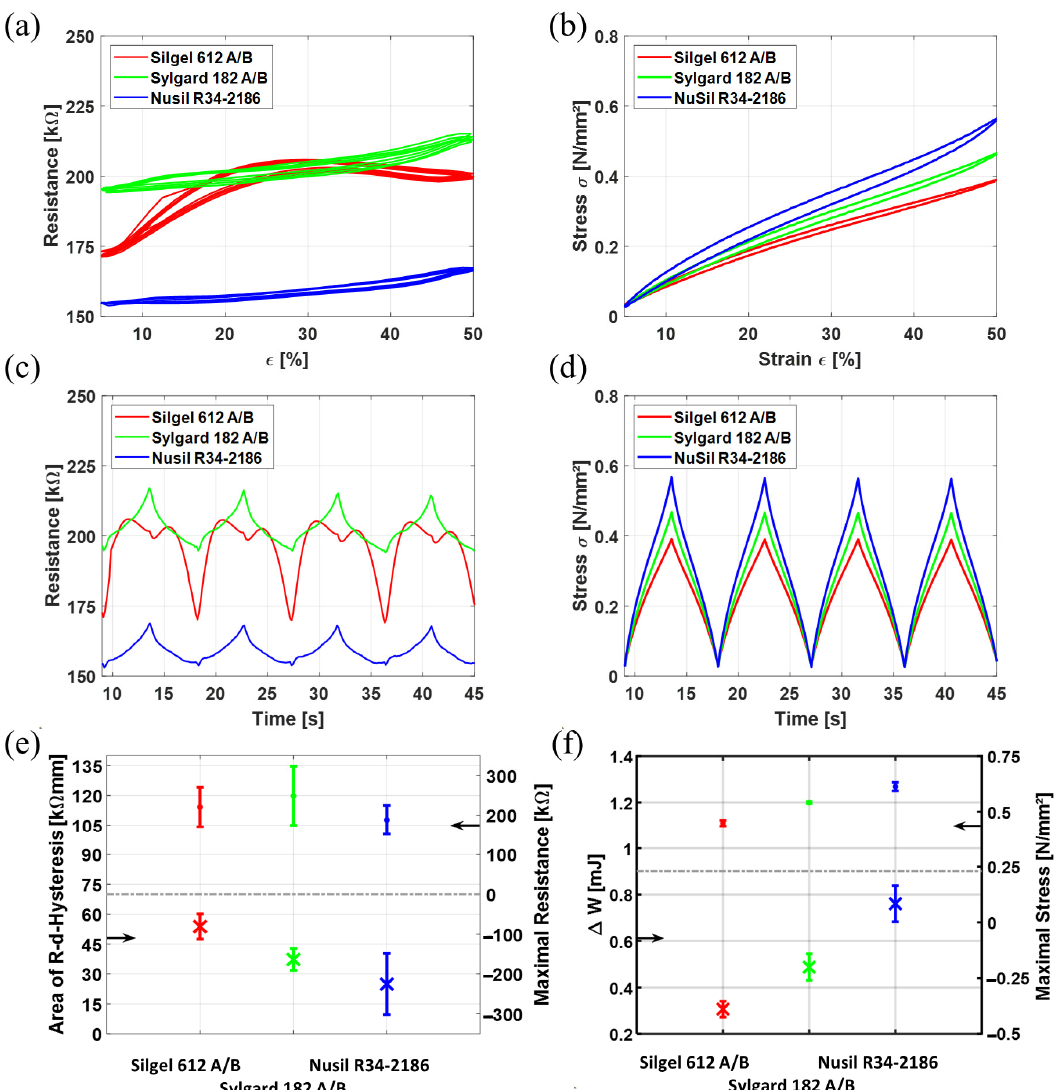
Figure 6. Influence of the used silicone on the electrical resistance and the mechanic behavior of the electrode: ( a ) Resistance–strain curves; ( b ) Stress–strain curves; ( c ) Resistance over time; ( d ) Stress over time; ( e ) Top: maximal resistance at ε = 50% = max, bottom: area of resistance–displacement– hysteresis: ( f ) Top: maximal stresses at ε = 50% = max, bottom: Work loss Δ W (corresponds to area of force–displacement hysteresis).